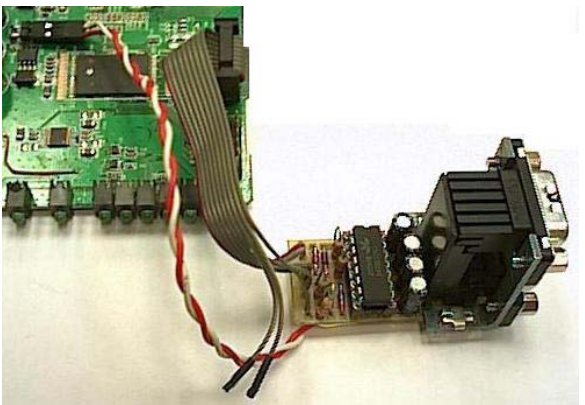
Figure 7. Integrated Circuit used to provide two serial